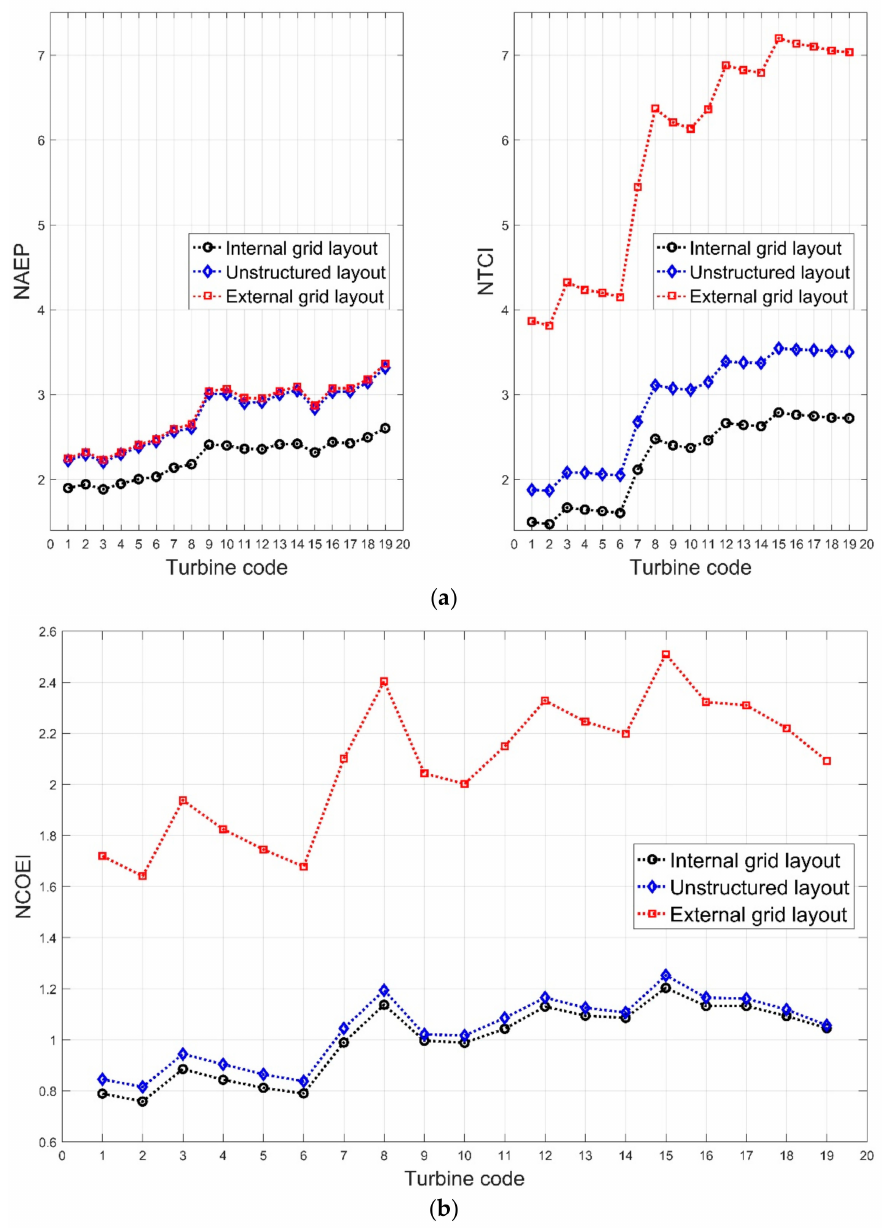
Figure 8. Results for single turbine cases and ObjFun1 for all layouts. ( a ) Normalized annual energy production and normalized total cost index; ( b ) Normalized cost of energy